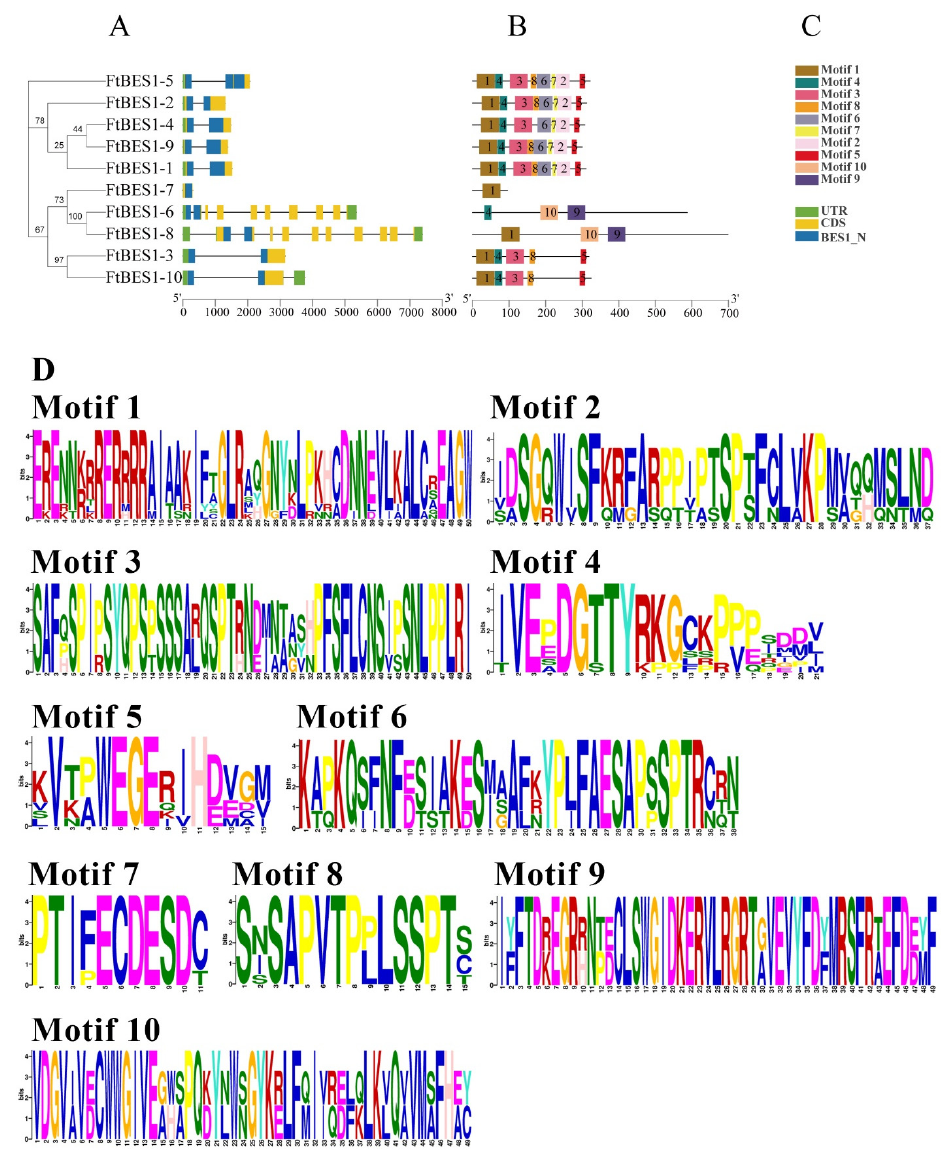
Figure 2. Phylogenetic tree, gene structure map, and motif analysis of FtBES1 gene members. ( A ) Phylogenetic tree of FtBES1 gene members with a duplicate value of 1000 using MEGA7.0 soft armor was constructed. ( B ) Gene structure of Tartary buckwheat FtBES1 , green box indicates 5 (cid:48) and 3 (cid:48) end UTRs, yellow box indicates exons, black line indicates introns, and blue box indicates structural domain BES1_N. ( C ) Motif composition of Tartary buckwheat FtBES1 protein; different motifs are indicated by different colors. ( D ) Sequence logo of the FtBES1 proteins